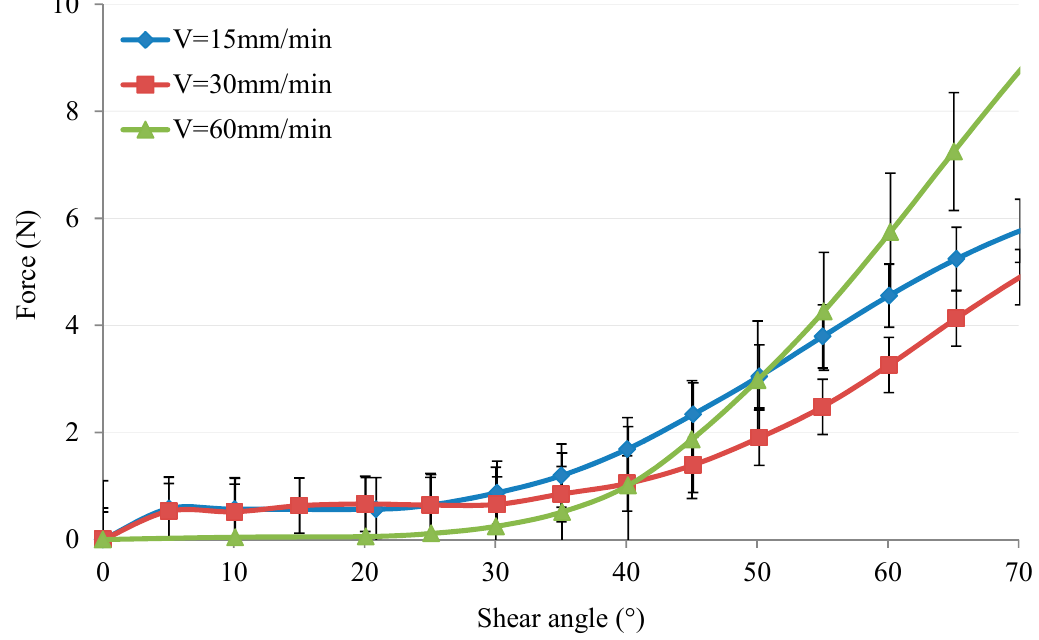
Figure 11. The shear angle vs. load under variation of speed.